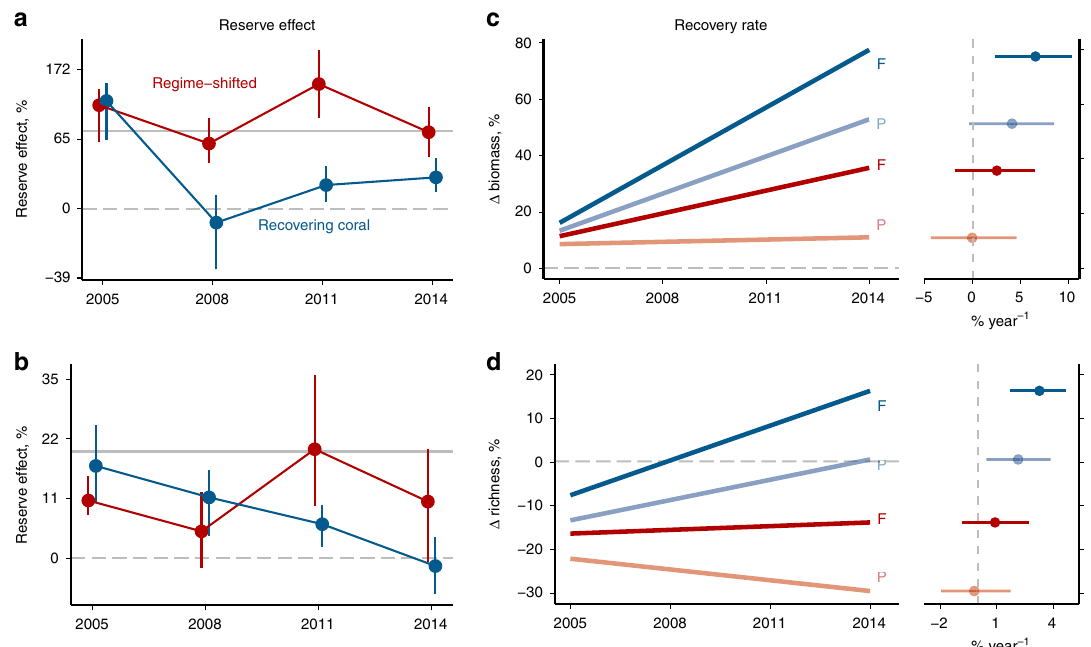
Fig. 3 Post-bleaching marine reserve effects on fi sh biomass and species richness from 2005 – 2014. Reserve response ratio (reserve/ fi shed) for biomass ( a ) and richness ( b ) on a percentage scale (0 = no effect), with jackknife resampling error bars and grey lines indicating no reserve effect (dashed) and pre-bleaching reserve effect (solid). Recovery of biomass ( c ) and richness ( d ) relative to pre-bleaching levels ( y = 0, dashed grey line), for fi shed (F) and protected (P) reefs. Lines are posterior median predictions for each reef regime and reserve status, with points showing the posterior median rate of biomass or richness recovery per year (±95% certainty intervals) ( n sites = 7 fi shed-recovering, 5 protected-recovering, 5 fi shed-shifted, 4 protected-shifted). See Supplementary Fig. 3 for corresponding observed biomass and richness values, and Supplementary Figs. 5 – 6 for biomass and richness recovery trajectories at each reef. Source data are provided as a Source Data fi